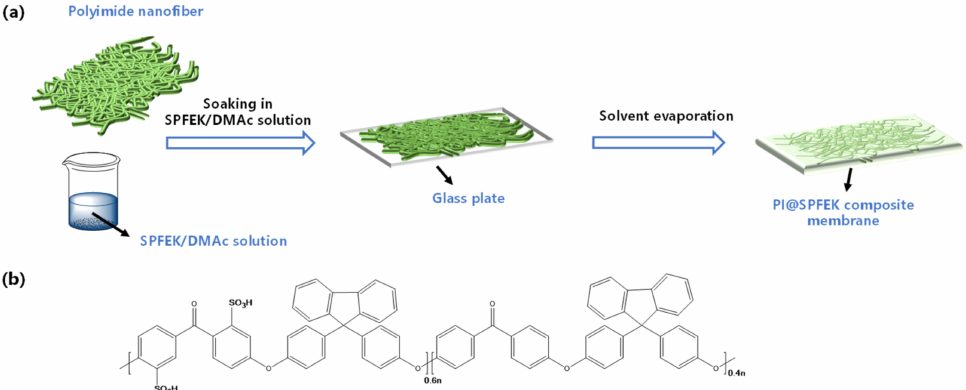
Figure 1. ( a ) Schematic illustration of the fabrication process of the PI@SPFEK membrane; ( b ) Chemical structure of SPFEK. PI@SPFEK is a sulfonated poly (fluorenyl ether ketone) (SPFEK)-impregnated polyimide nanofiber mat composite